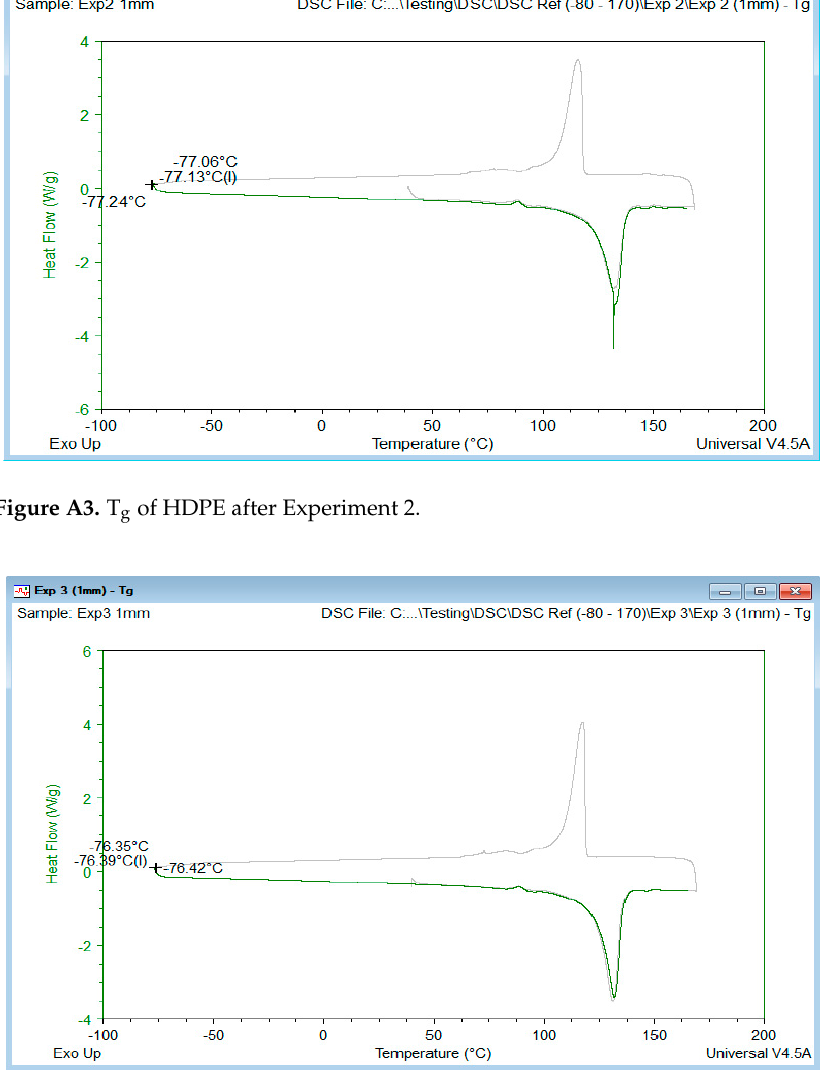
16 of 19 Figure A1. T g of virgin HDPE.